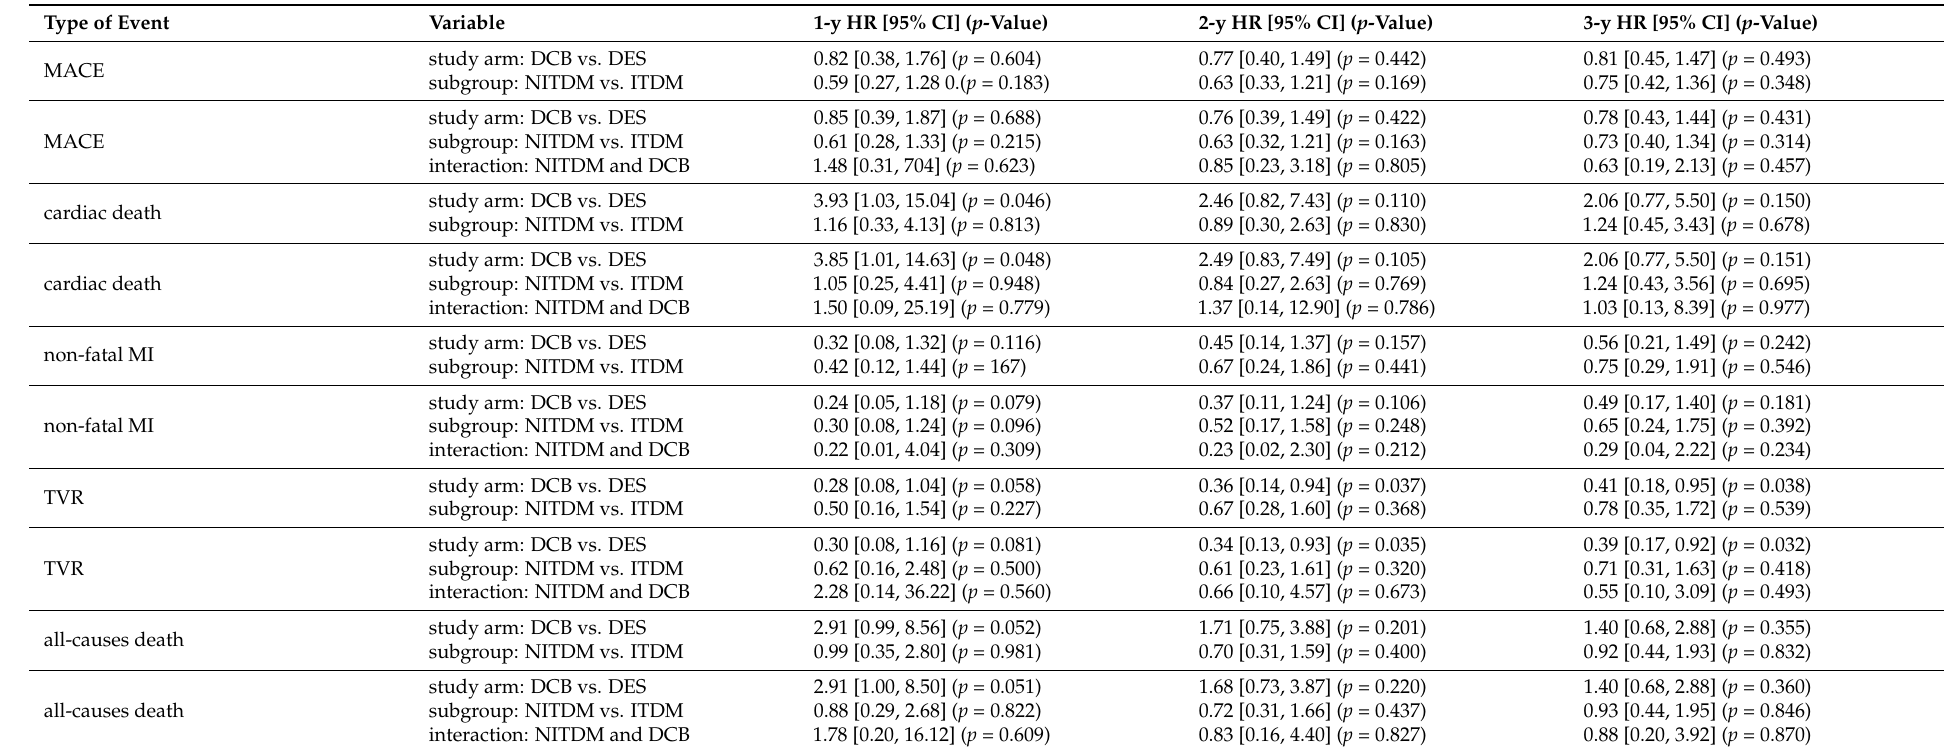
Table 3. Cox regressions stratified by study center with and without interaction with